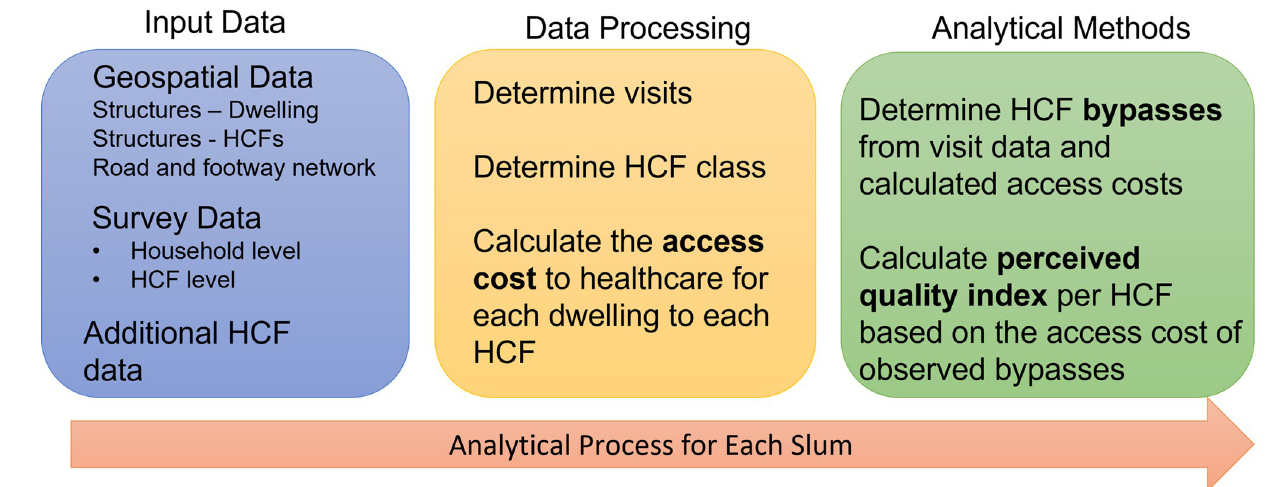
Fig 1. Summary of research